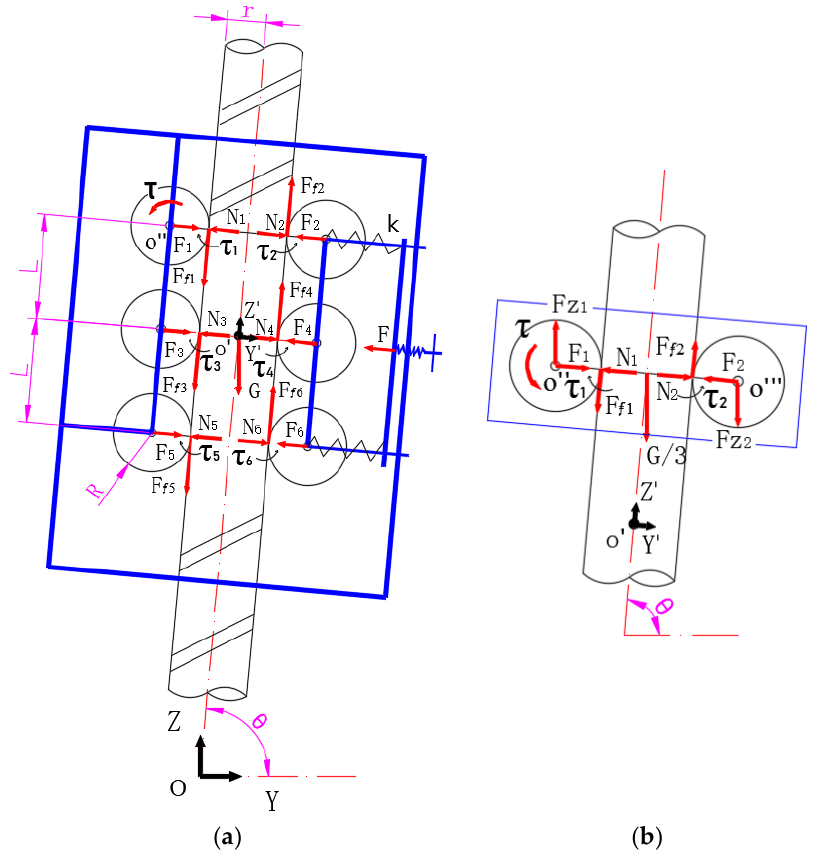
Figure 7. Force diagram of the robot when it has a downward movement trend. ( a ) Force diagram in the YOZ coordinate plane, ( b ) simplified equivalent force diagram.